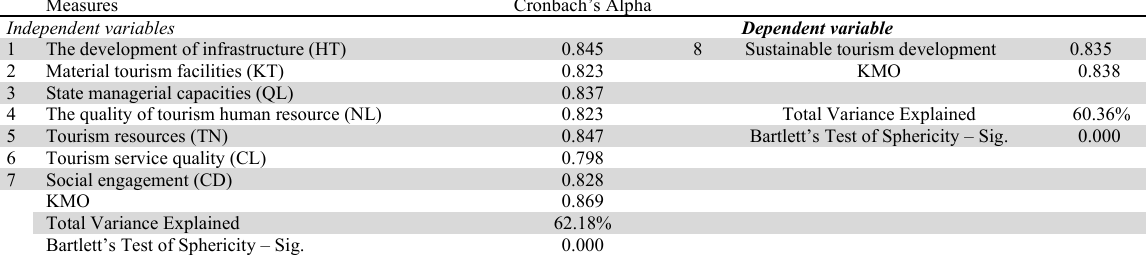
The results of assessing the reliability of scales by Cronbach’s Alpha Measures